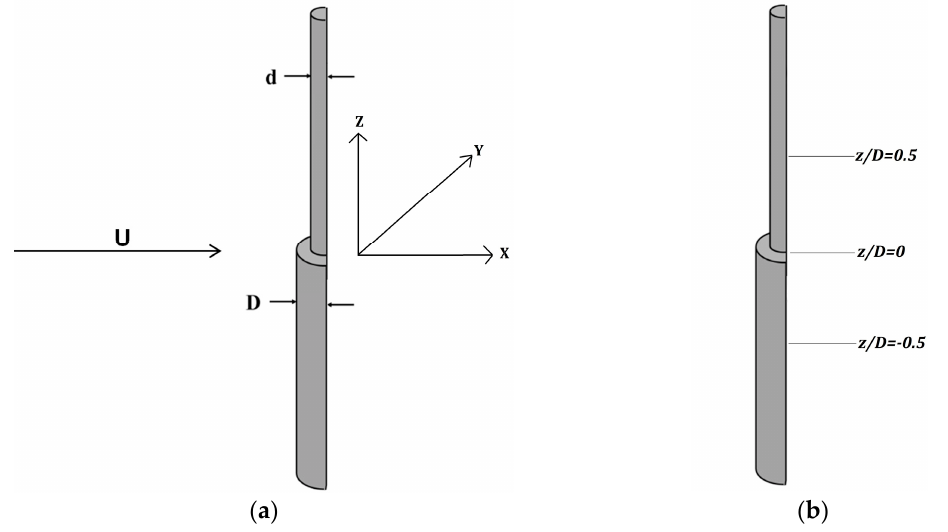
Figure 1. Cylinder configuration; ( a ) flow direction and coordinate description; and ( b ) measuring zones.